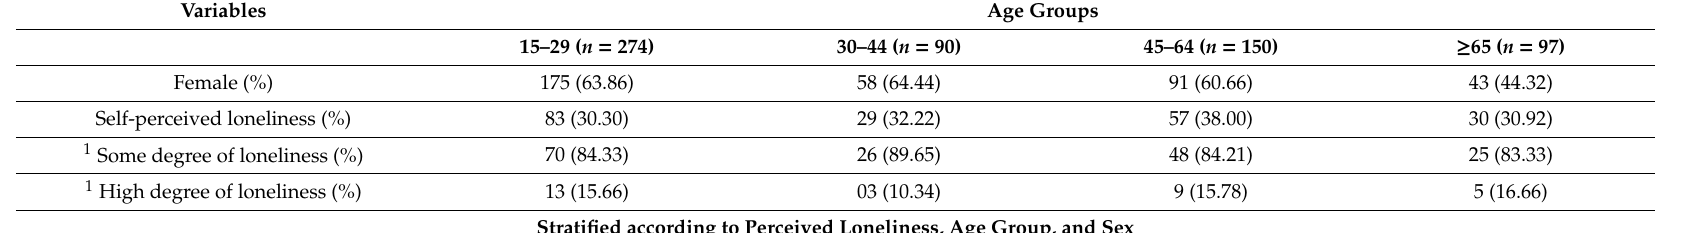
Table 1. Description of the sample related to loneliness and lifestyle by age and